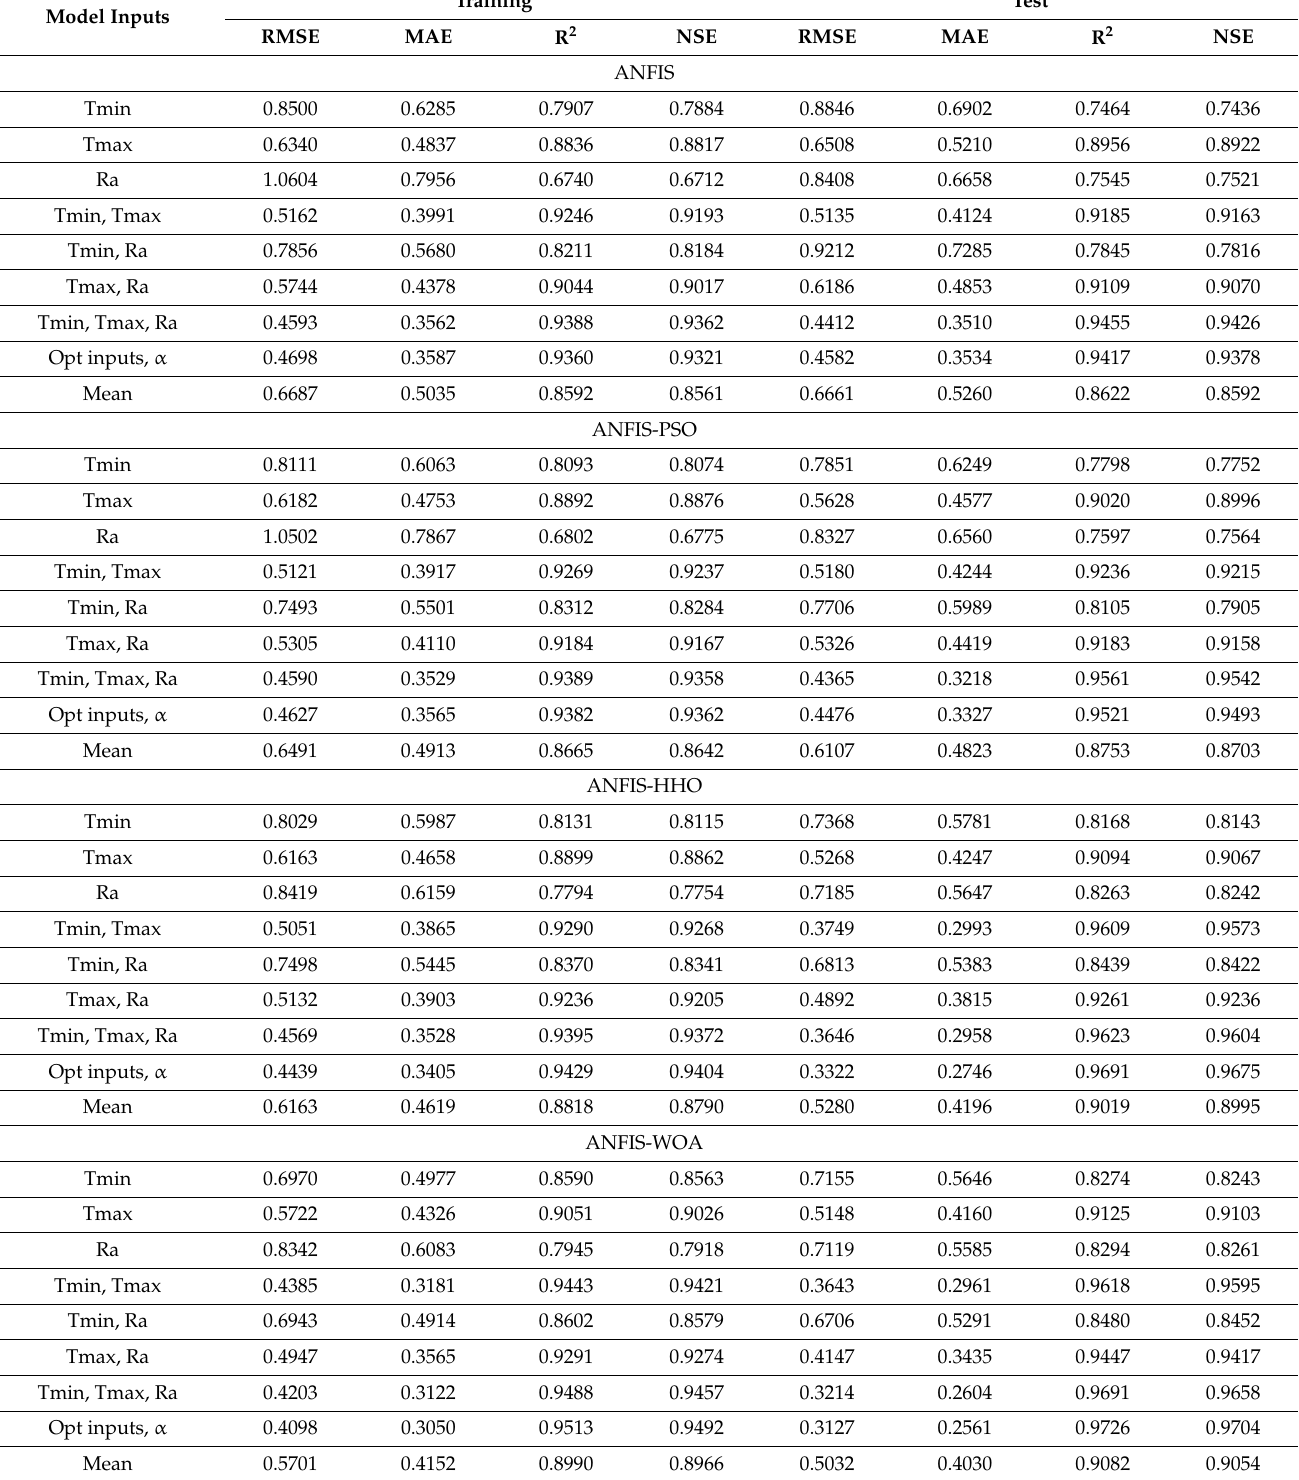
Table 4. Training and testing performances of the models for monthly Epan prediction—Jingzhou